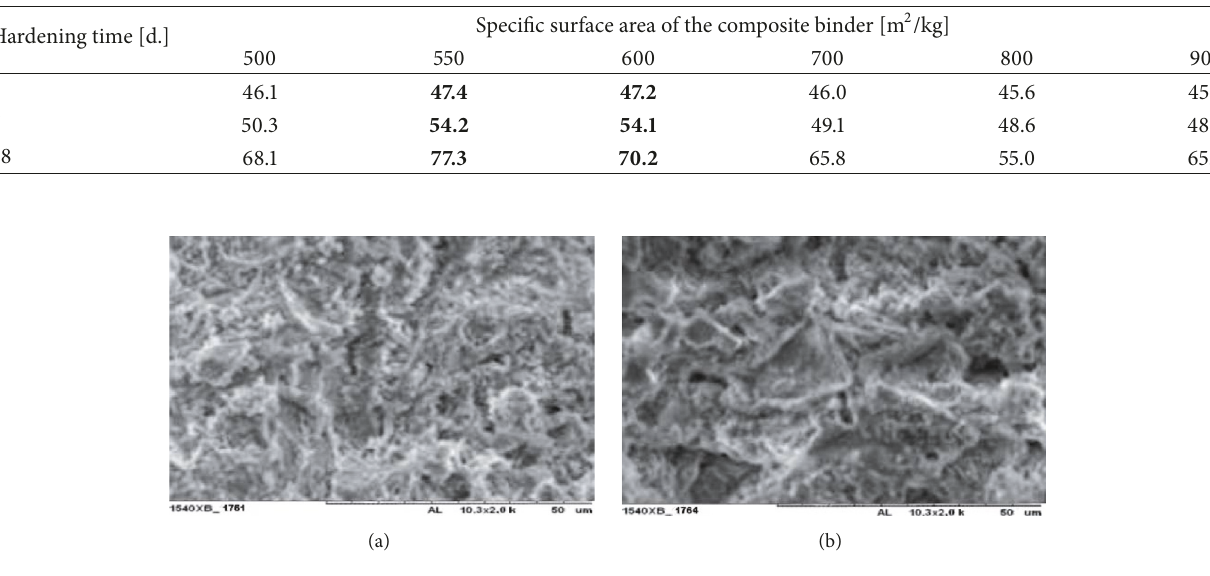
Table 5) to different specific surface area (𝑆 sp ) : 500, 550, 600, 700, 800, and 900 m 2 /kg (Table